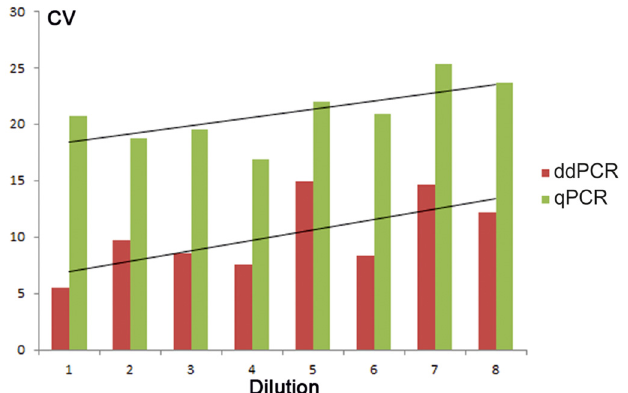
Fig 1. Statistically significant differences between the both techniques coefficients of variation (CV) for standard curve of RHD exon 10 replicates. A trend of increasing CVs with decreasing DNA concentrations can be seen in both methods